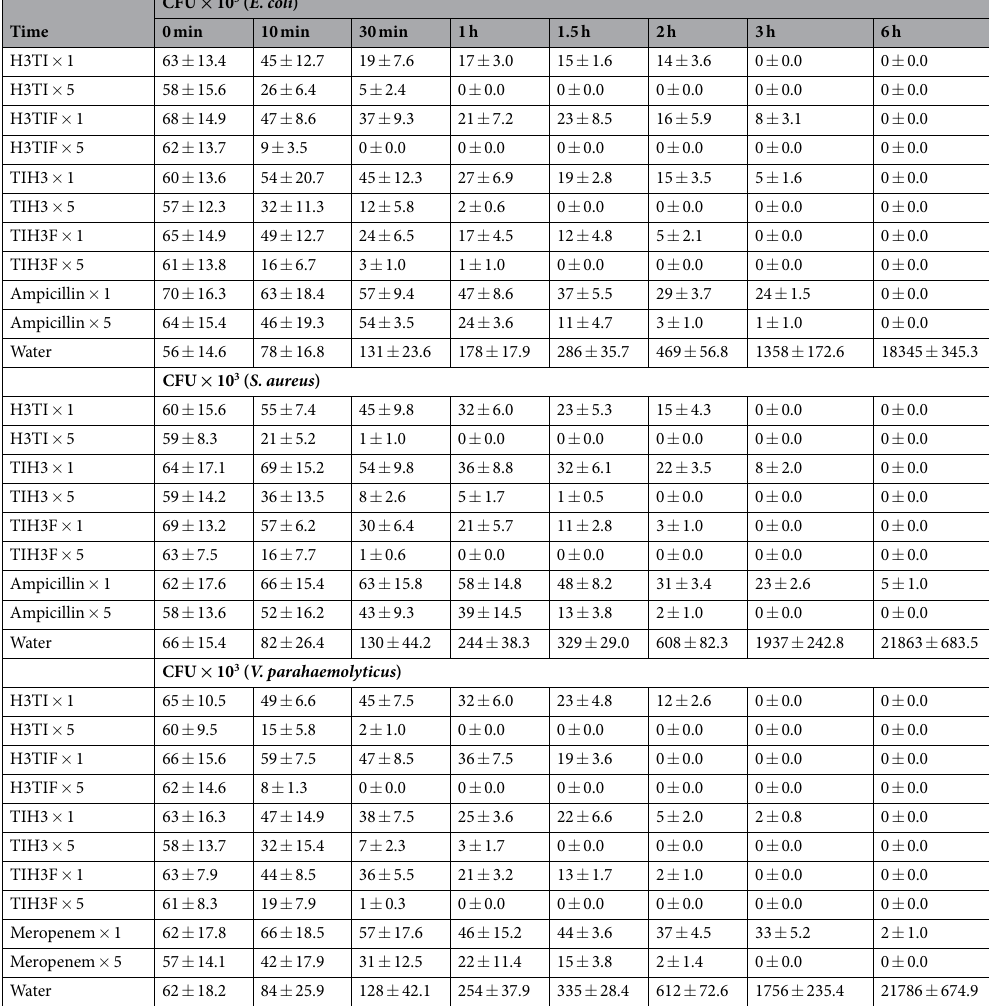
Table 5. Bacterial killing kinetics of four hybrid peptides. CFU: colony forming unit; 1xMIC and 5xMIC of samples were used in this experiment; The MICs of H3TI, H3TIF, TIH3, TIH3F and ampicillin against E. coli 08040726 are 9.38, 4.69, 150, 4.69 and 0.12 µ g/mL, respectively; H3TI, H3TIF, TIH3, TIH3F and meropenem MICs to V. parahaemolyticus are 4.69, 2.37, 37.5, 9.38 and 0.47 µ g/mL,